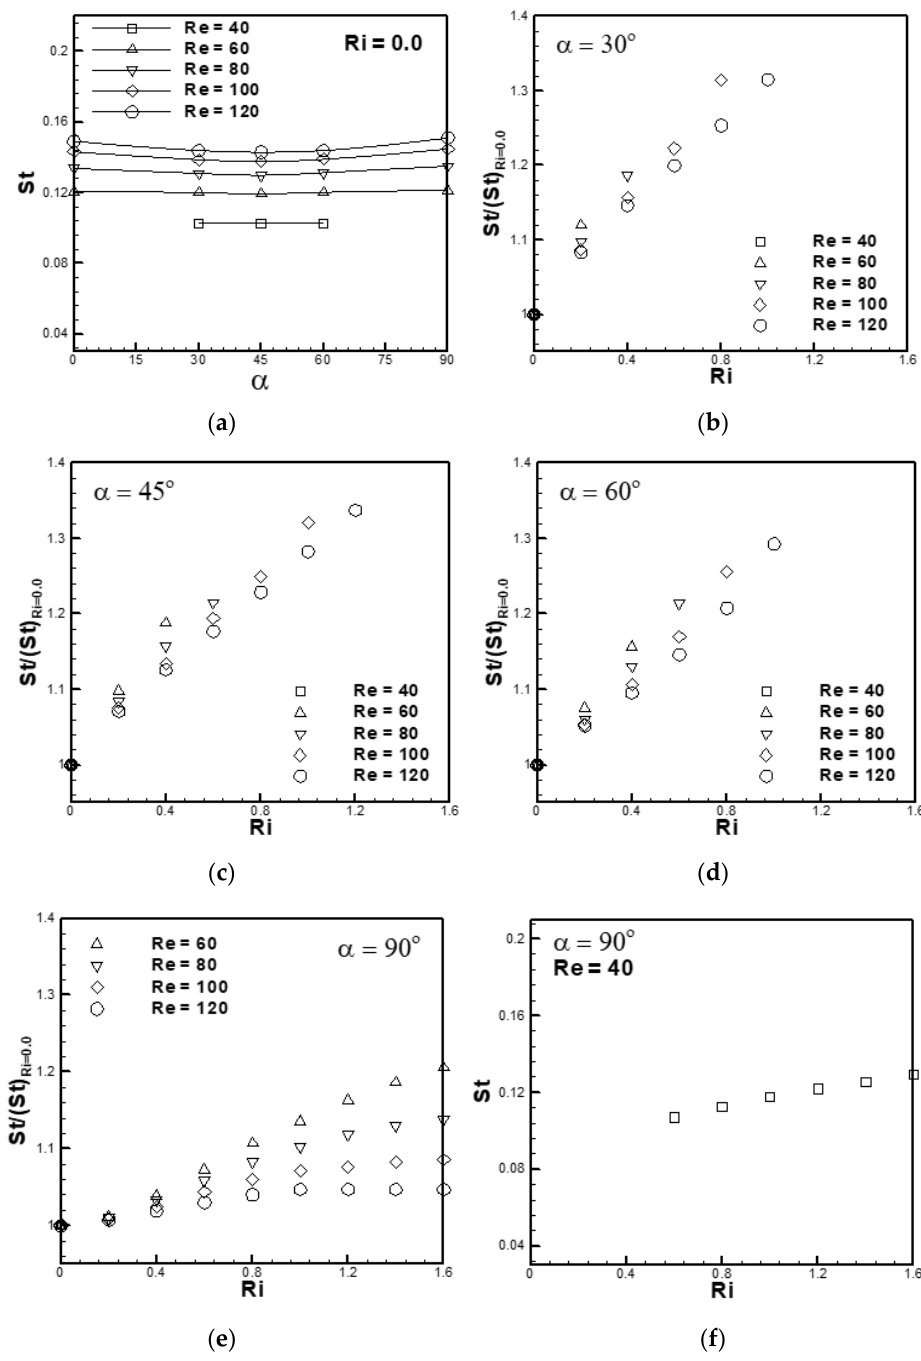
Figure 11. St- α and St-Ri characteristics at ( a ) Ri = 0, 40 ≤ Re ≤ 120 for 0 ◦ ≤ α ≤ 90 ◦ and ( b – f ) at 0 ≤ Ri ≤ 1.6, 40 ≤ Re ≤ 120 for 30 ◦ ≤ α ≤ 90 ◦